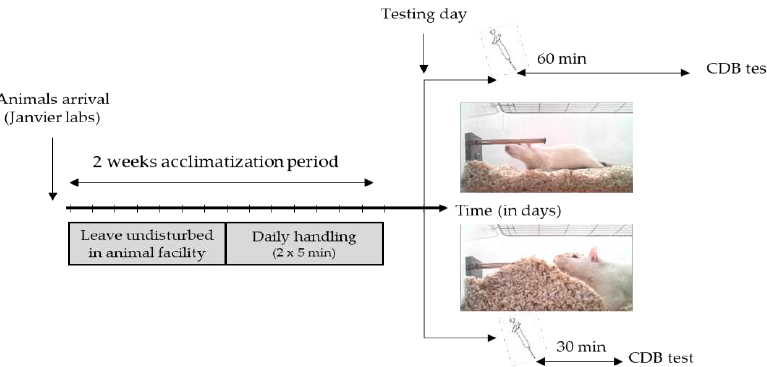
Figure 1. Experimental design. There was a 2 week acclimatization period, where animals were first left undisturbed for the first week, then handled twice daily in order to acclimate the animals to the experimenter. On the testing day, 60 or 30 min after an oral gavage, the Conditioned-Defense Bur- ying (CDB) task was performed. Burying (CDB) task was